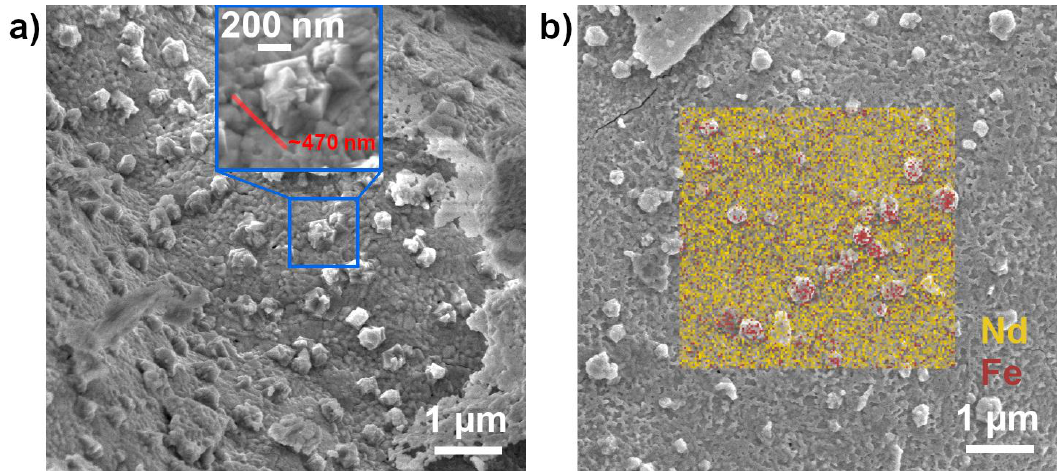
Figure 4. SEM images of the Nd 0.6 Ca 0.4 FeO 3 perovskite after reductive treatment with humidified H 2 at 973 K (ratio H 2 :H 2 O ≈ 32:1, p = 1 bar). Image ( a ) displays the exsolved particles, growing from the surface. The magnified particle (inset) has a diameter of ~470 nm. In image ( b ), an EDX mapping of Nd and Fe (overlay) confirms the iron nature of the nanoparticles (more Fe and less Nd at the positions where bright particles are visible in the secondary electron image).